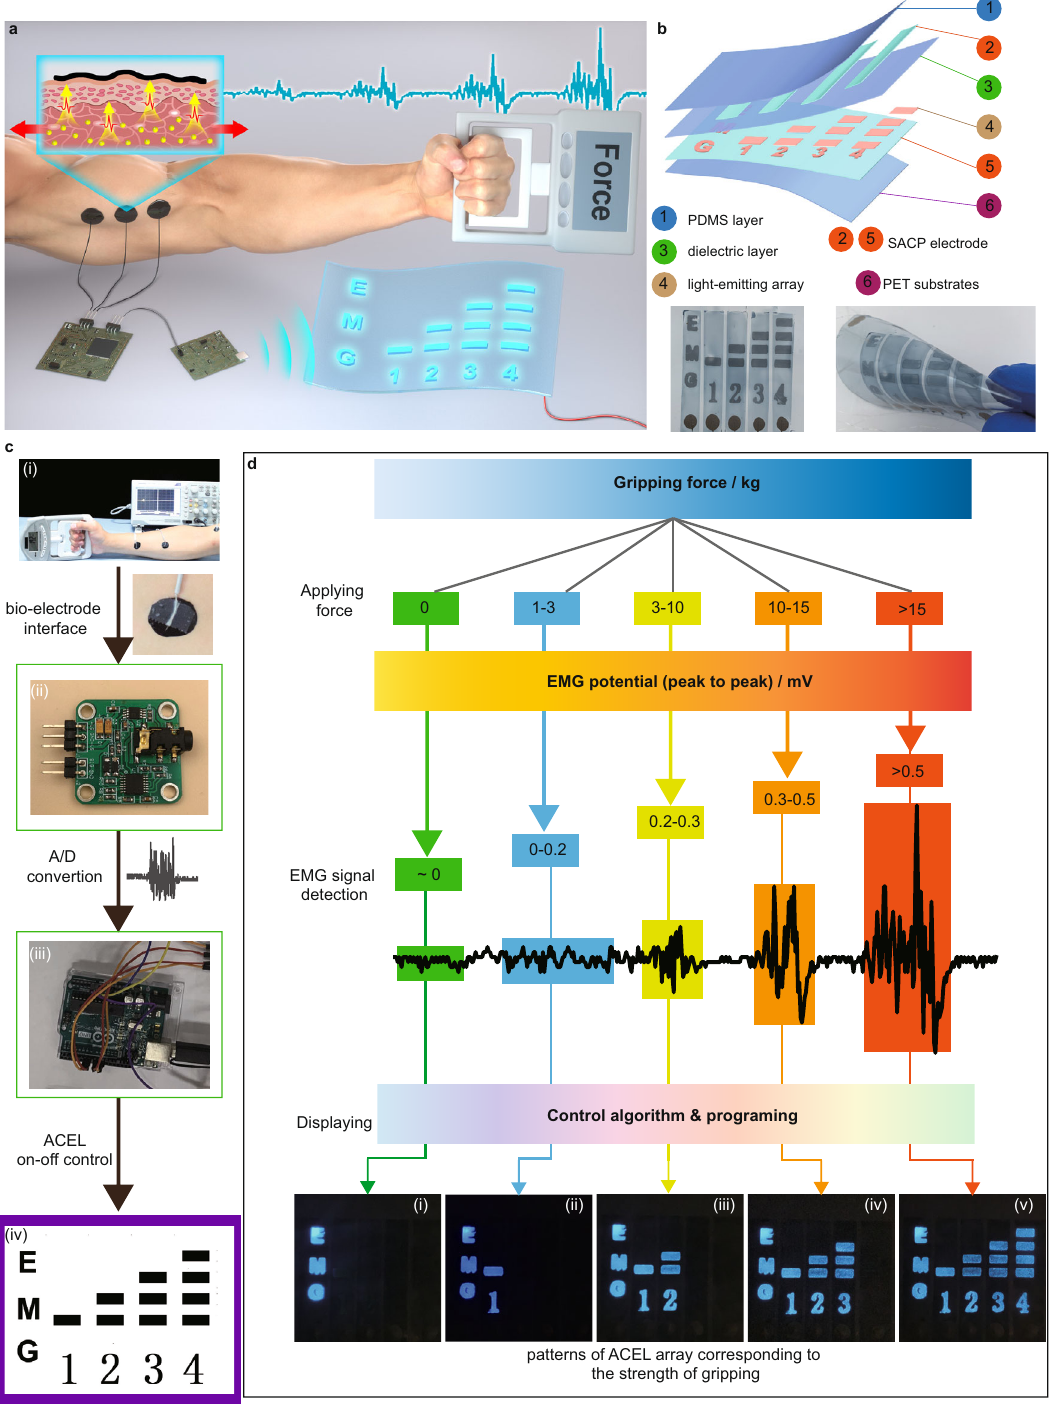
Fig. 6 Demonstration of an integrated EMG visualization system with an array of ACEL devices. a Schematic summary of the system with ACEL display controlled by EMG sensors. b ACEL display with patterned lighting arrays assembled by the transparent conductive fi lm. c Four functional units in the system: (i) conductive fi lm electrode for EMG signals transformation, (ii) commercial EMG sensors for data recording, (iii) commercial single-chip microcomputer for ACEL control, and (iv) fl exible ACEL devices for EMG signals display. d Patterns of fl exible ACEL display turning on and off based on the level of EMG test speed of 50 mm/min. To analyze the stability of adhesion force, various Adhesion forces of free-standing SACP fi lms adhering to various substrates contact times (0.5, 1, 30, 60, and 120 min) of the substrate in contact with were measured using a 180° peeling test with the mechanical testing machine. SACP fi lm were conducted by measuring the adhesion force of 180° peeling All substrates were treated using 3 M tape to remove surface contaminants. test. Cyclic adhesion force tests were performed. The adhesion force was Then, free-standing SACP fi lm was attached to the diverse substrates. The determined by averaging the peeling force ( F ) and then dividing the force by dimensions of the samples were 8-10 mm (width) and 60 – 80 mm (length). the width of the sample ( w ). Loading-displacement curves were conducted with a tensile mold at a peeling